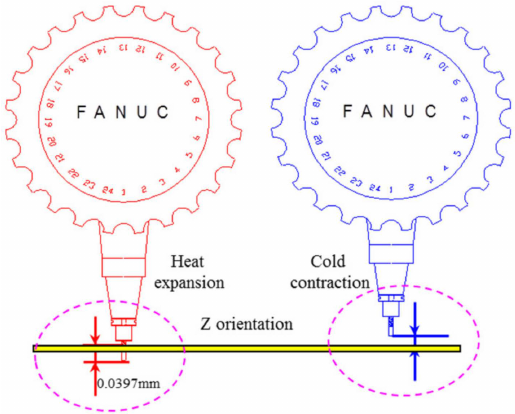
Figure 5. Thermal expansion and contraction of the spindle.